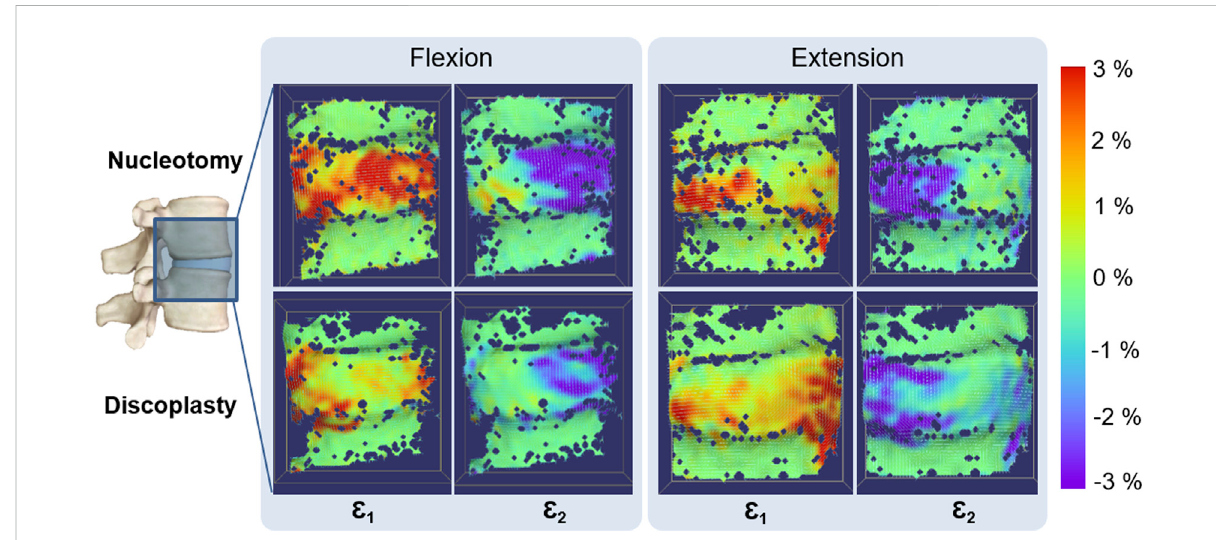
FIGURE 6 Typical distribution of Maximum ( Ɛ 1 ) and Minimum ( Ɛ 2 ) True Principal strains on the specimen surface in fl exion and extension. The dark blue spots on thespecimensurface correspond to the areas where the DIC algorithm could not correlate, in particular along theendplates. Only thedisc underwent large